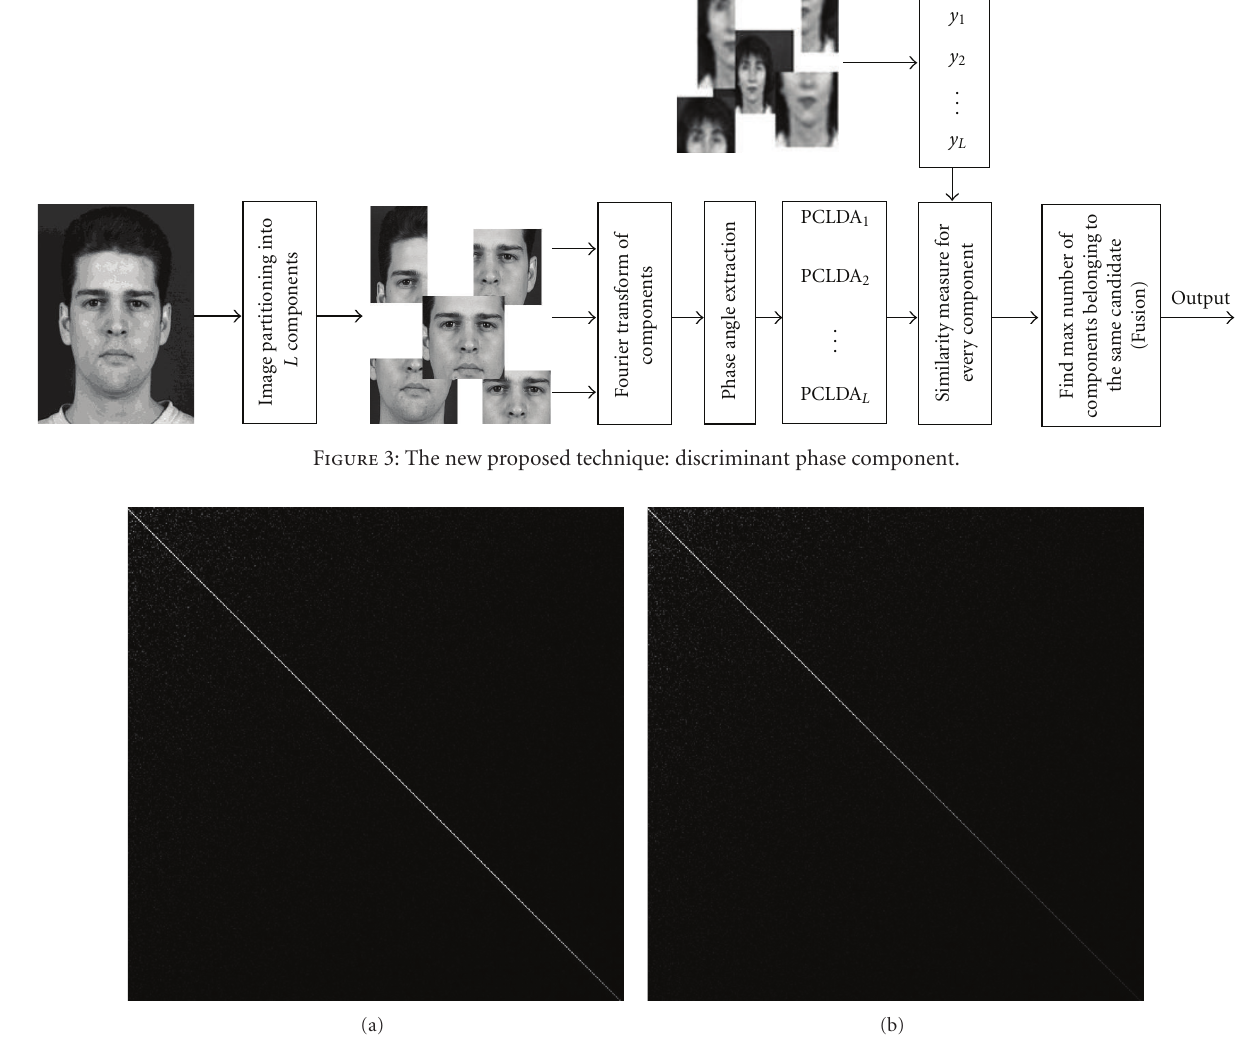
Figure 4: An example of the resultant between-class-scatter-matrix (on the left) and within-class-scatter-matrix (on the right) for a phase spectrum of a component face image.